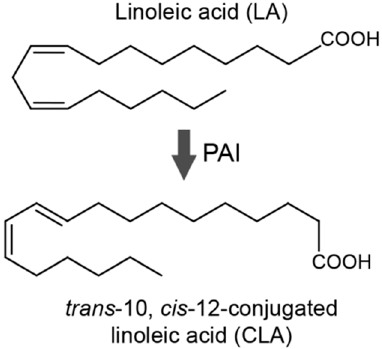
Figure 1. Conversion from linoleic acid to trans -10, cis -12-conjugated linoleic acid by PAI, a linoleic acid isomerase from Propionibacterium acnes ( P. acnes ).